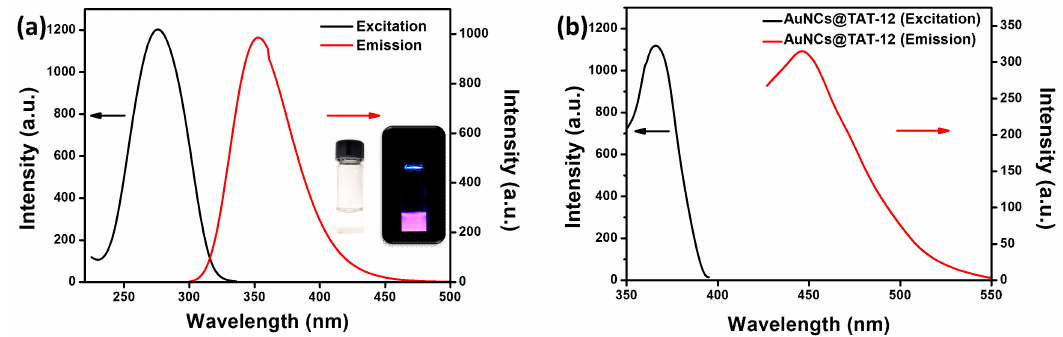
Figure 5. ( a ) Excitation spectrum of AuNCs@TAT-12 with fluorescence wavelength at 352 nm. Emission spectrum of AuNCs@TAT-12 under excitation wavelength of 273 nm. ( b ) Excitation spectrum of AuNCs@TAT-12 with fluorescence wavelength at 448 nm. Emission spectrum of